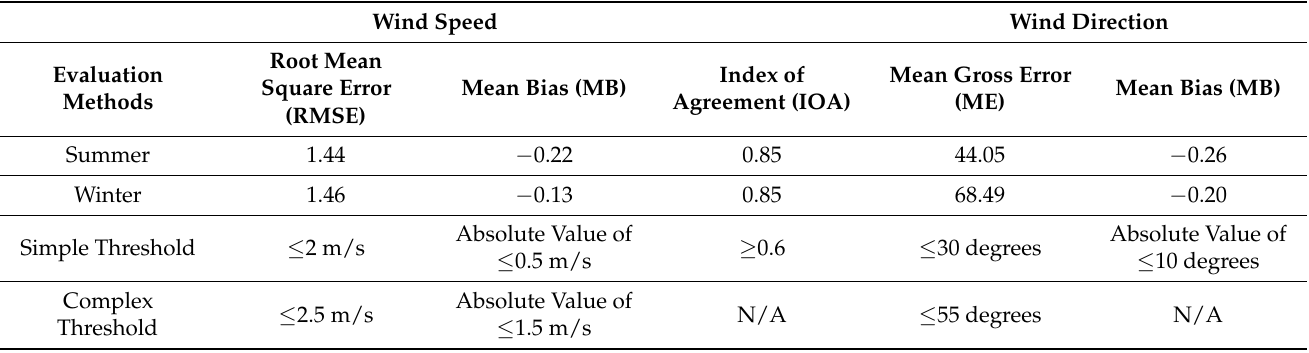
Table 3. Results of WRF simulation evaluation and thresholds. Wind Speed Wind